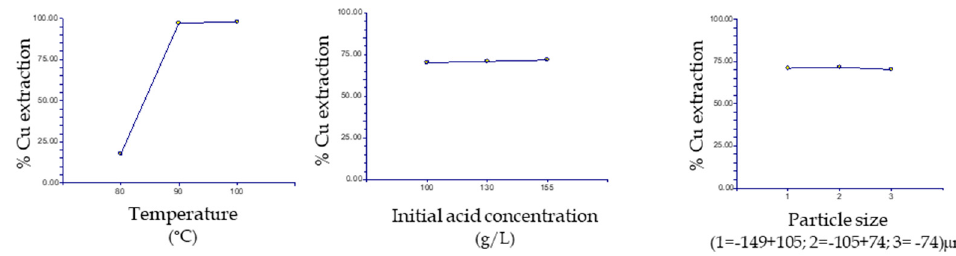
Figure 8. Correlations of temperature, initial acid concentration and particle size with extraction of copper.